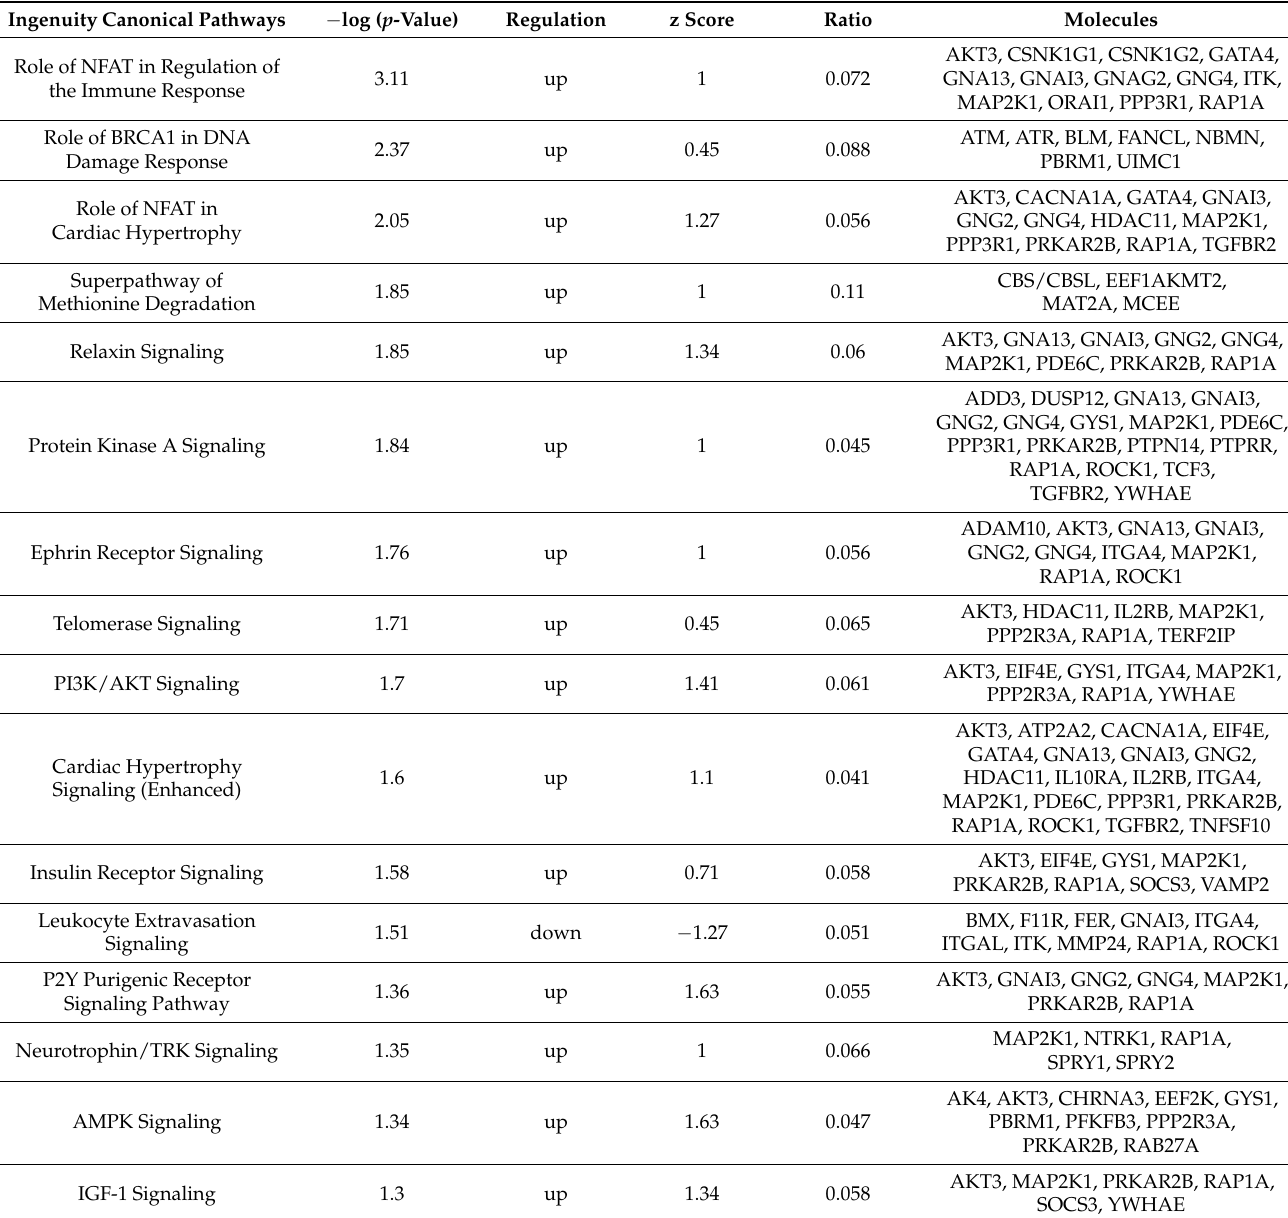
Table 1. List of pathways regulated by